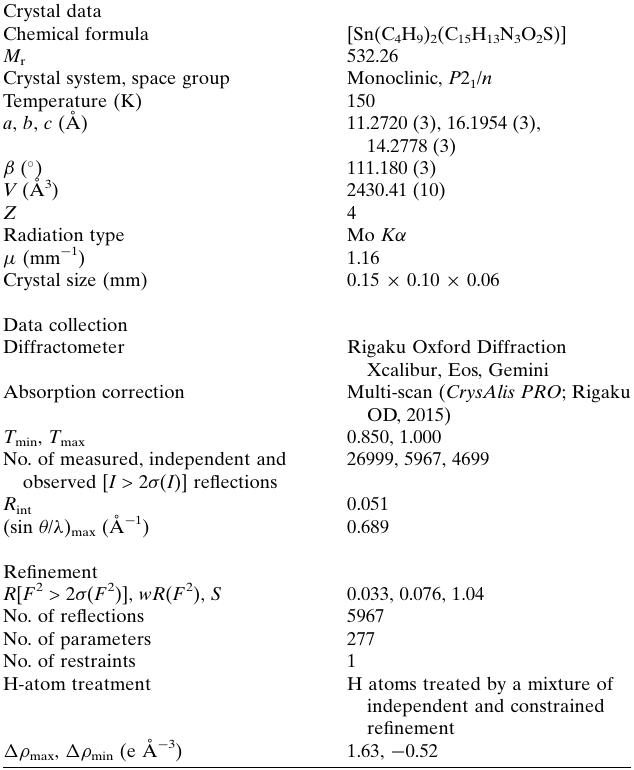
Table 6 Experimental details. Crystal data Chemical